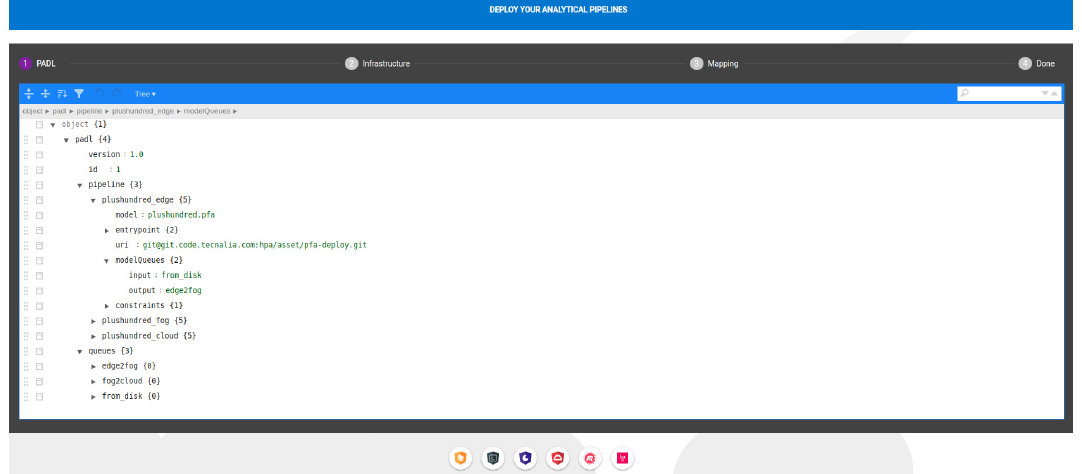
Figure 8. Angular client overview: this client provides a stepper component including three JSON editors (PADL JSON editor, infrastructure JSON editor and DeployMap JSON editor) and a confirma- tion